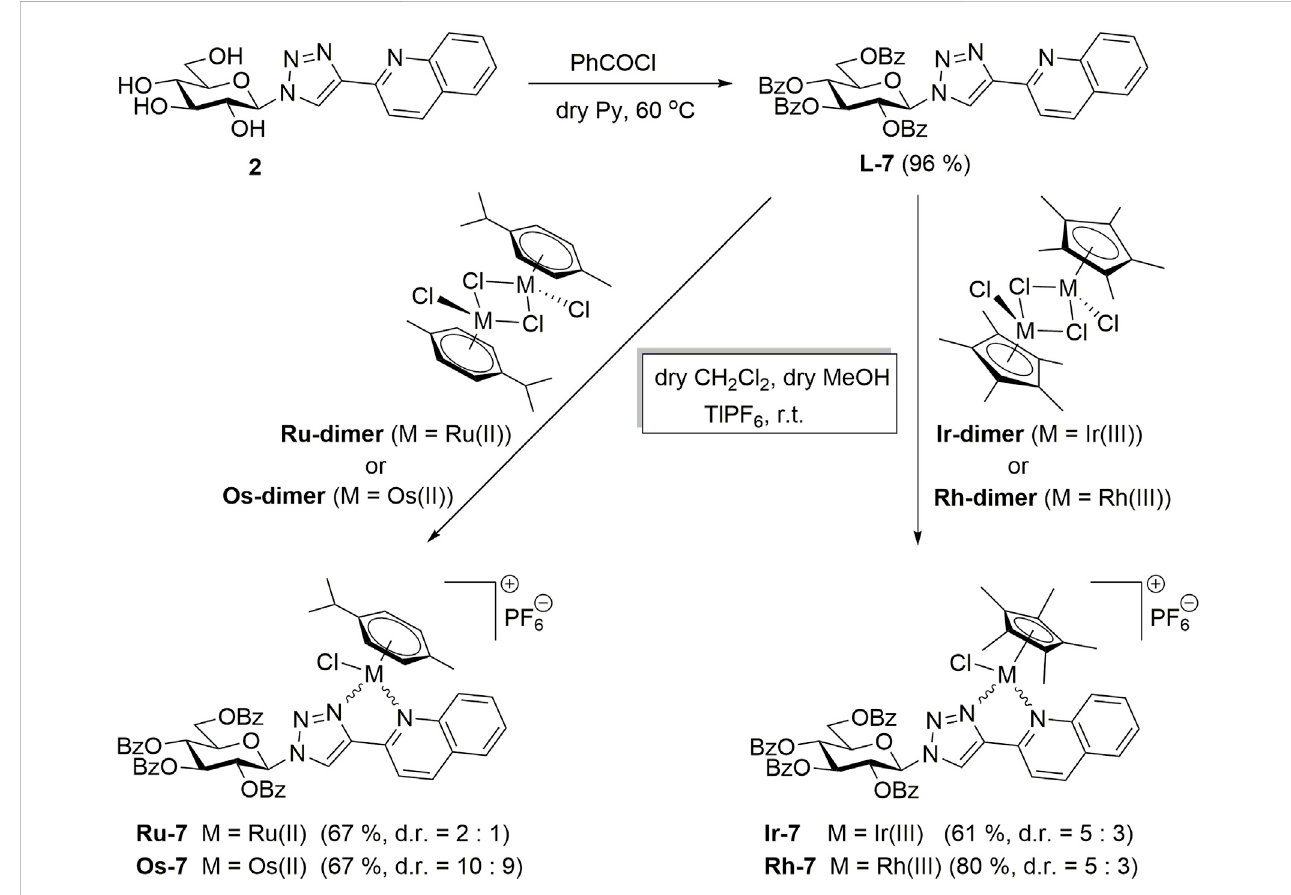
FIGURE 2 Synthesis of1-(2 ’ ,3 ’ ,4 ’ ,6 ’ -tetra- O -benzoyl- β - D -glucopyranosyl)-4-(quinolin-2-yl)-1,2,3-triazole and its[( η 6 - p -cym)M II (N-N)Cl]PF 6 (M =Ru, Os) and [( η 5 - Cp*)M III (N-N)Cl]PF 6 (M = Ir, Rh)